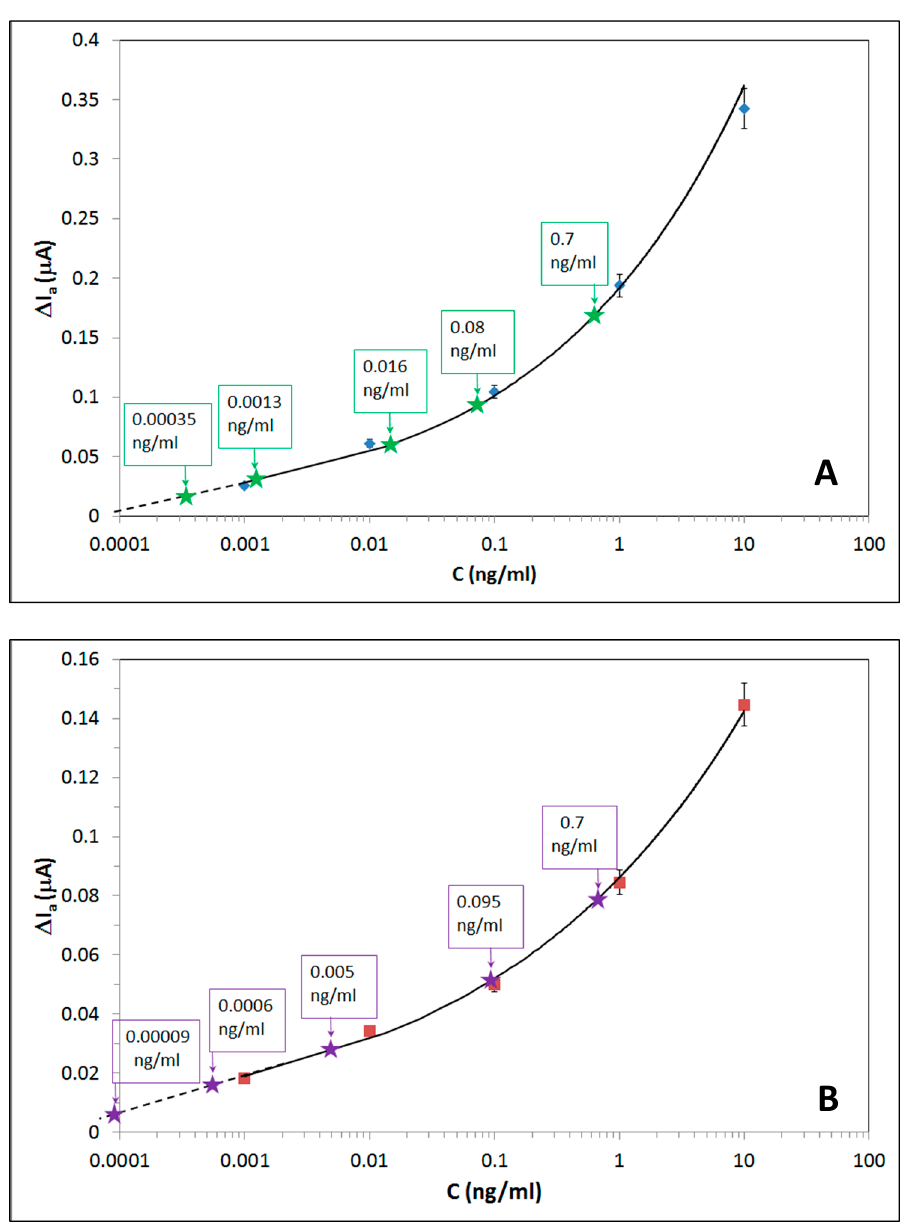
Figure 4. The concentration dependences of changes in anodic current at 0.2 V upon binding of Hg 2+ ( A ) and Pb 2+ ( B ) ions to respective aptamers. The star points correspond to real sample data; the concentration values are given next to those points.